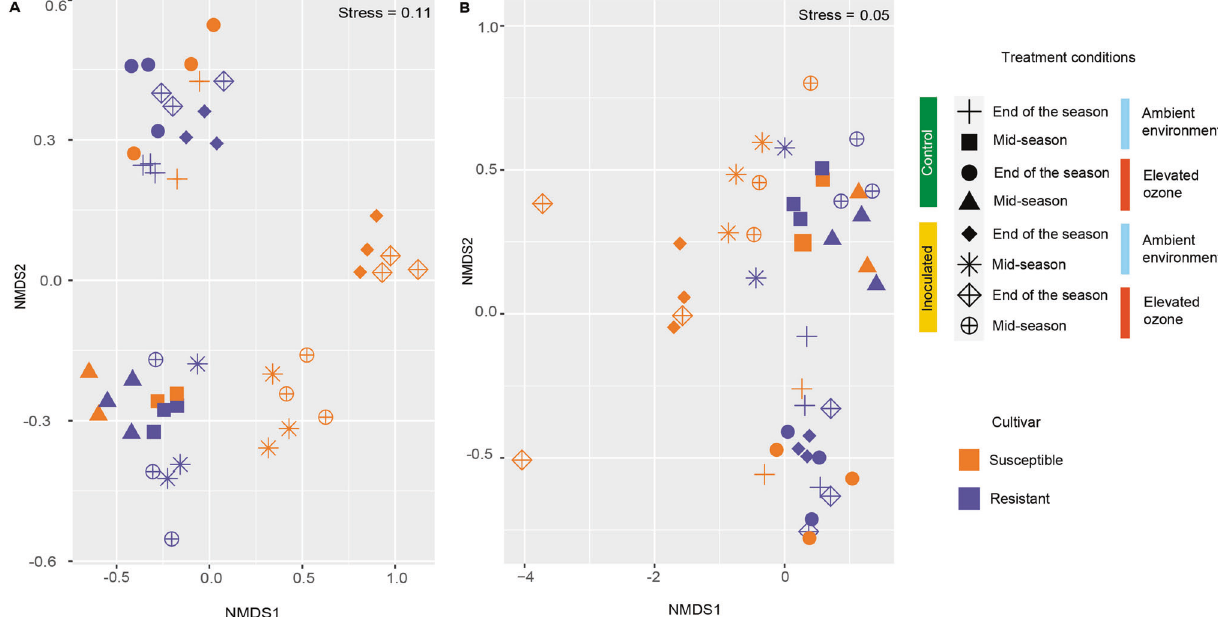
Fig. 3 Elevated O 3 changes microbial community structure on susceptible cultivars challenged with pathogen infection, but not on resistant cultivars. A Nonmetric Multidimensional Scaling (NMDS) ordination comparing the bacterial community diversity across two cultivars, environmental conditions, and time of sampling. B NMDS ordination comparing the eukaryotic community diversity across two cultivars, environmental conditions, and time of